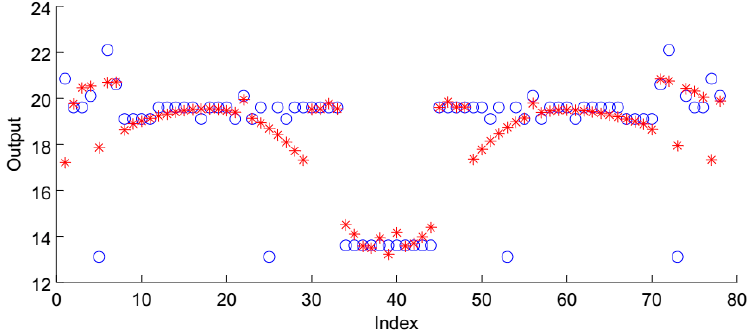
and are symbols representing the